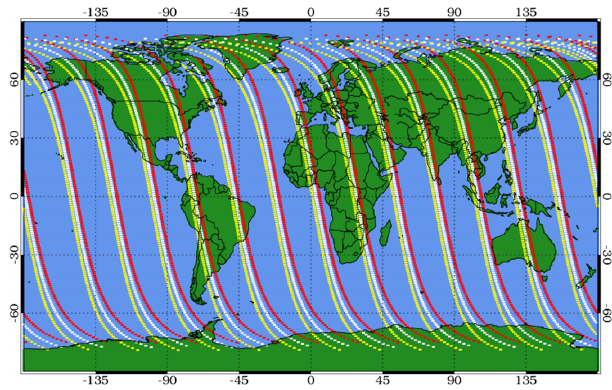
Figure 1. Daily coverage provided by the OMPS LP instrument mounted on the SNPP satellite. The tangent point for the LOS cor- responding to each observation is indicated, with red, white, and yellow circles depicting the left, center, and right slit observations,